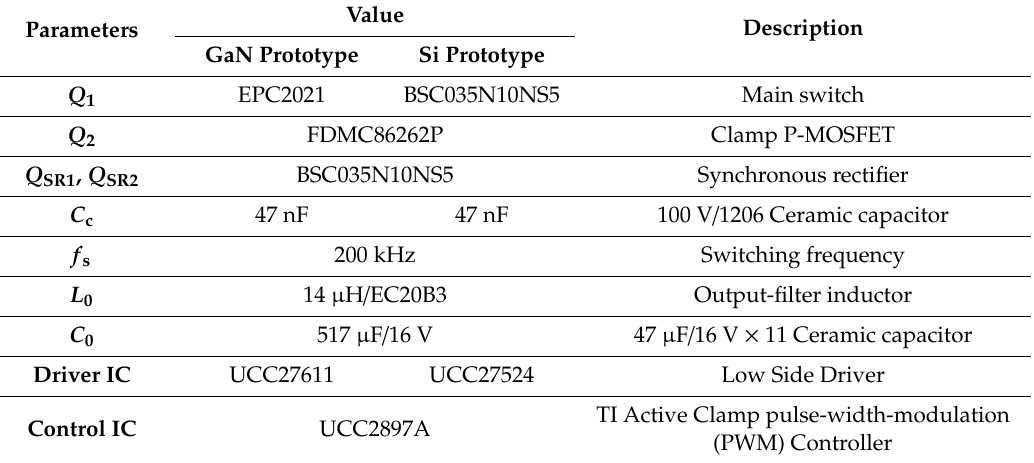
Figure 7. Photograph for GaN-based prototype with EPC2021: ( a ) Top view; ( b ) bottom view. Table 4. Key components and parameters in two prototypes.